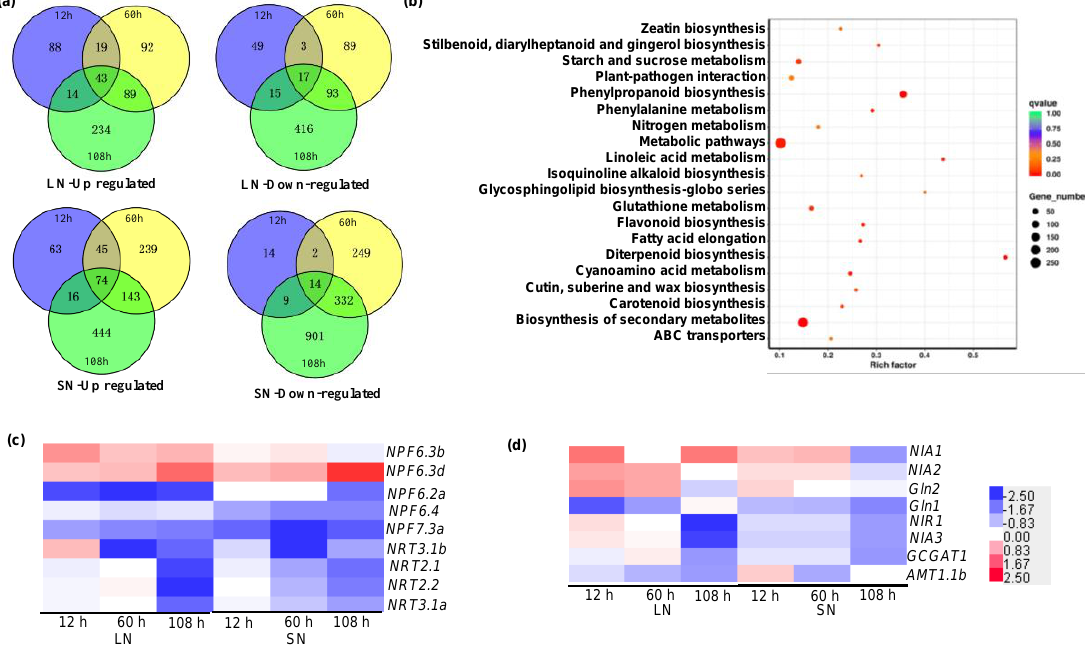
Figure 6. The DEGs involved in NO 3 − uptake and metabolism. ( a ) Venn diagrams showed the up- and downregulated significantly differentially expressed genes (DEGs) identified by RNA-seq in the wild-type and zmga3ox roots at 12, 60, and 108 h after LN and SN treatments, respectively; ( b ) list of the top 20 significant enriched KEGG pathway of significantly regulated DEGs. ( c , d ) Heatmap showed the DEGs involved in NO 3 − uptake and transport ( c ), N assimilation and NH 4 + uptake ( d ). Genes annotated by MaizeGDB gene model were shown with gene name. Different expression levels were shown as log 2 FC, blue for downregulation and red for upregulation, as shown in color bar.